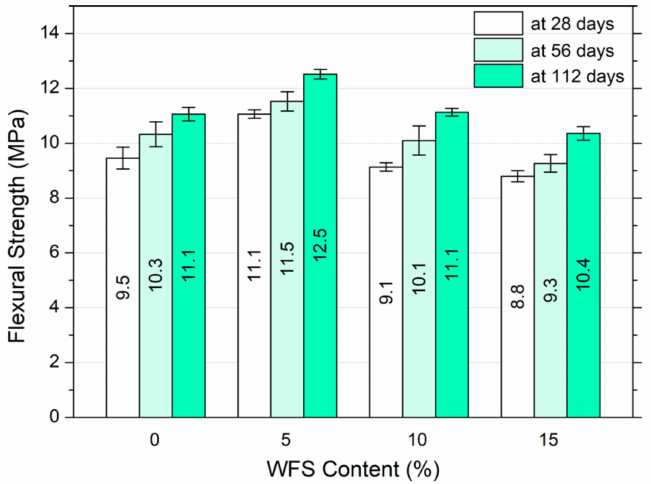
Figure 4. Flexural strength